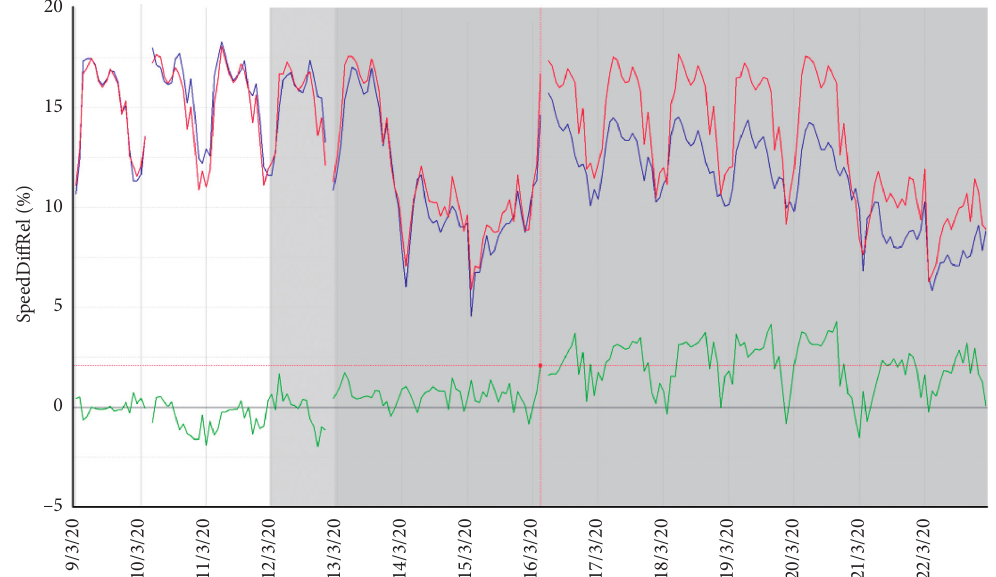
Figure 9: Period before and after declaring the state of emergency from 9 March to 22 March 2020. SpeedDiffRel in percentage points by